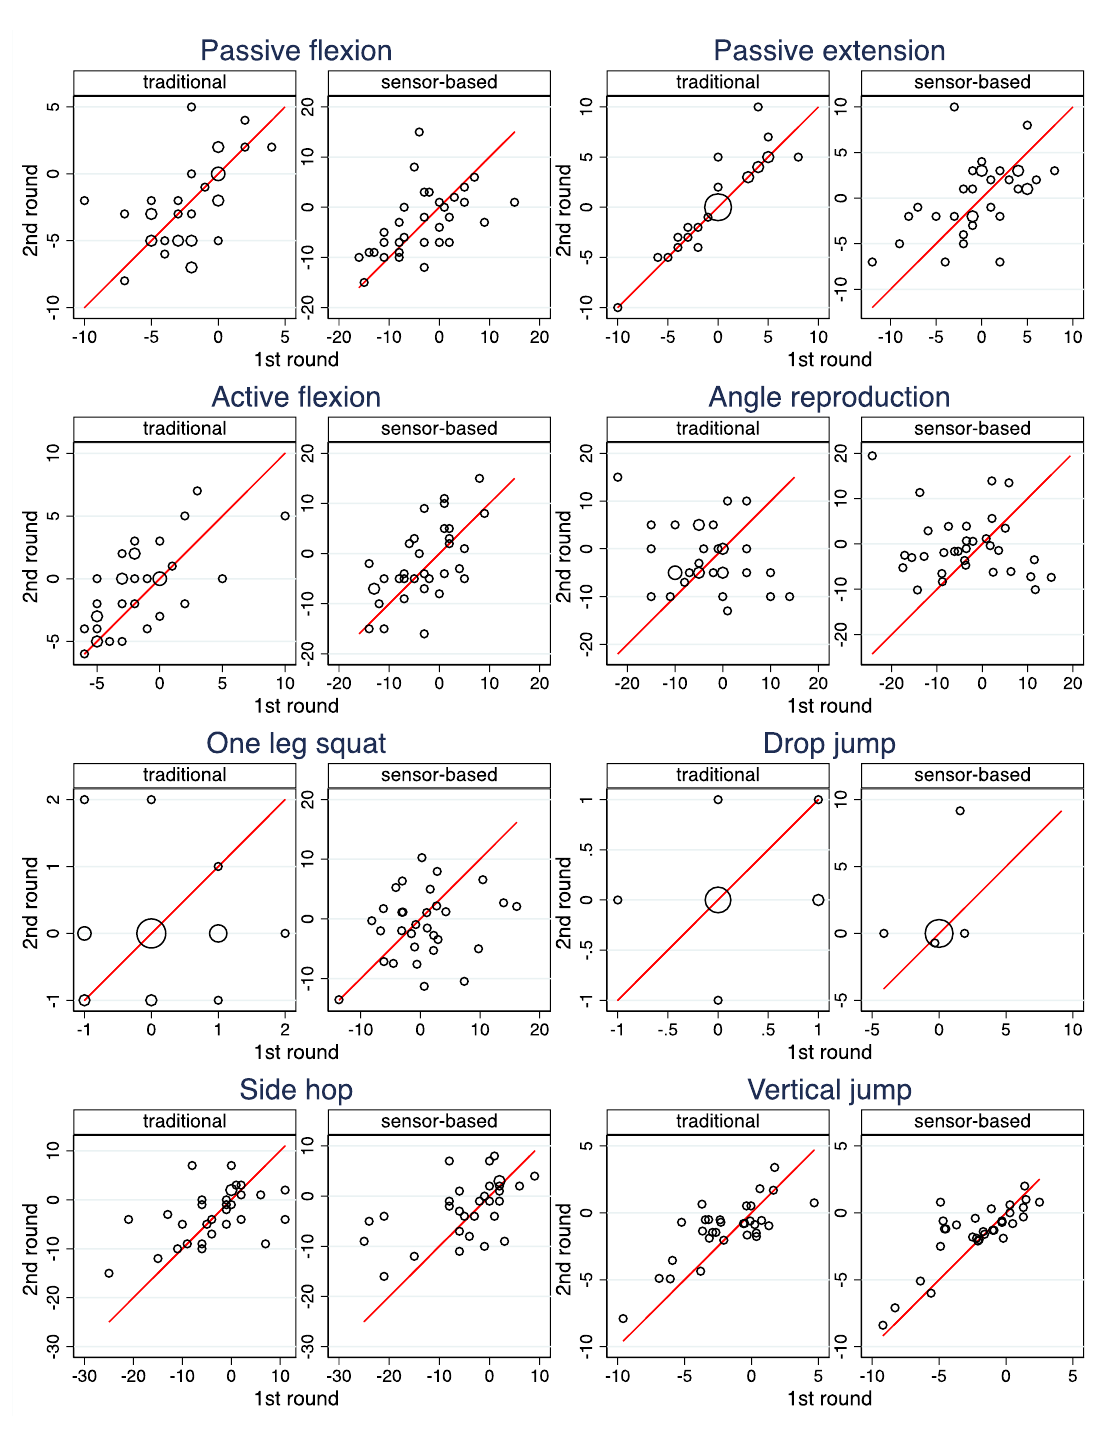
Figure 2. Scatterplots of the computed side differences in the second and the first round. The area of the circles is proportional to the number of observations. The line indicates equality of the two computed values.